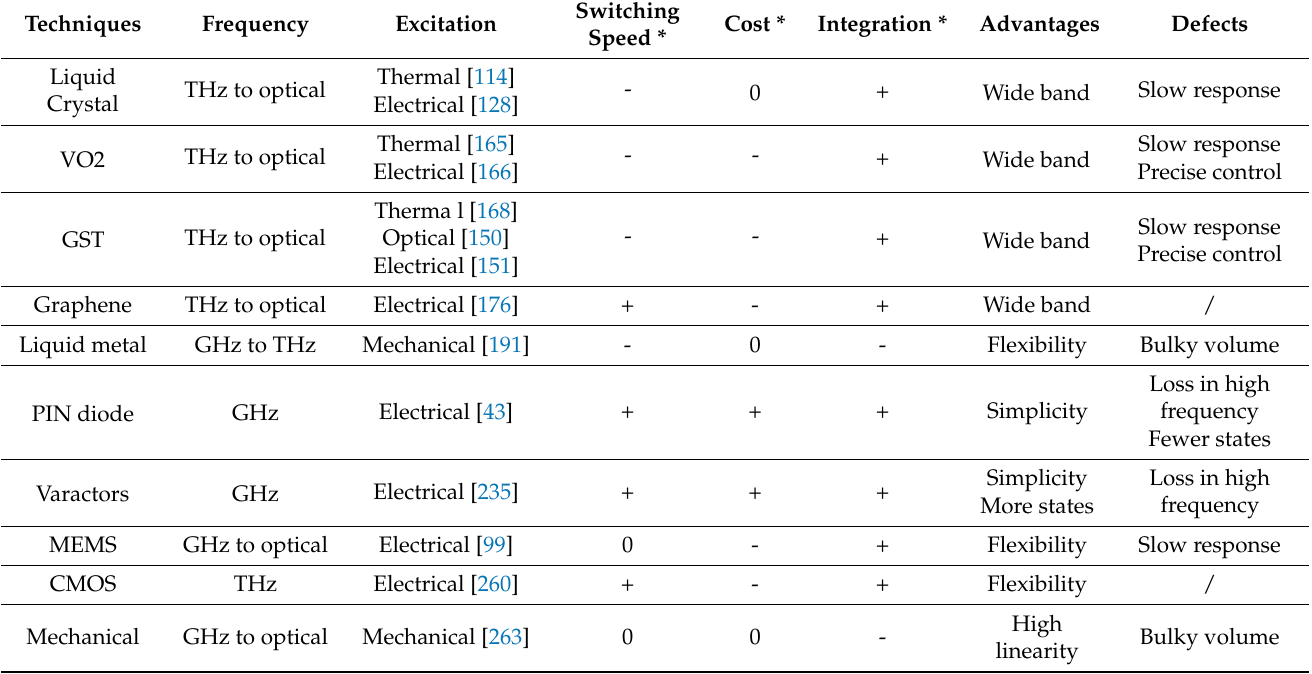
Table 1. Summary on the comparison among different